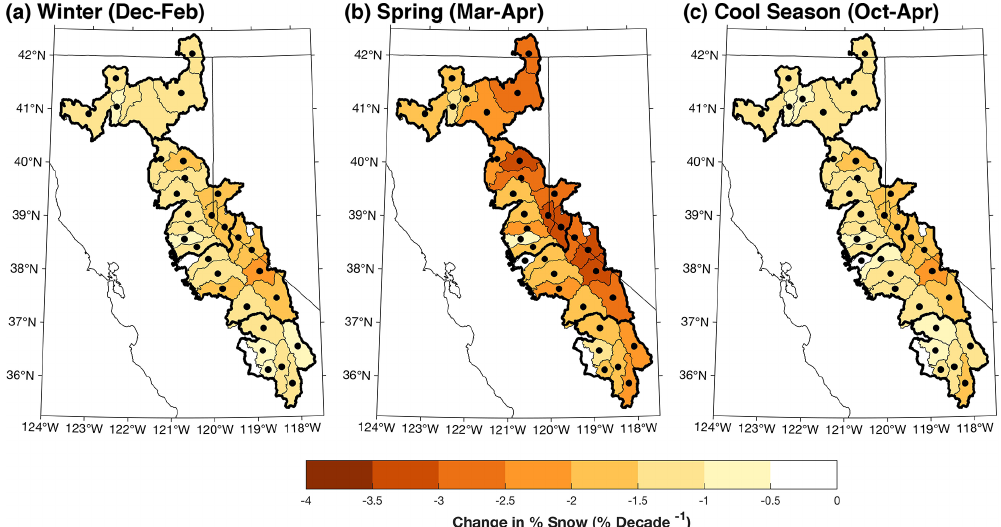
Figure 4. As in Fig. 3 but with trends averaged over HUC 8 watersheds. Filled black circles indicate statistically significant ( p < 0 . 05)